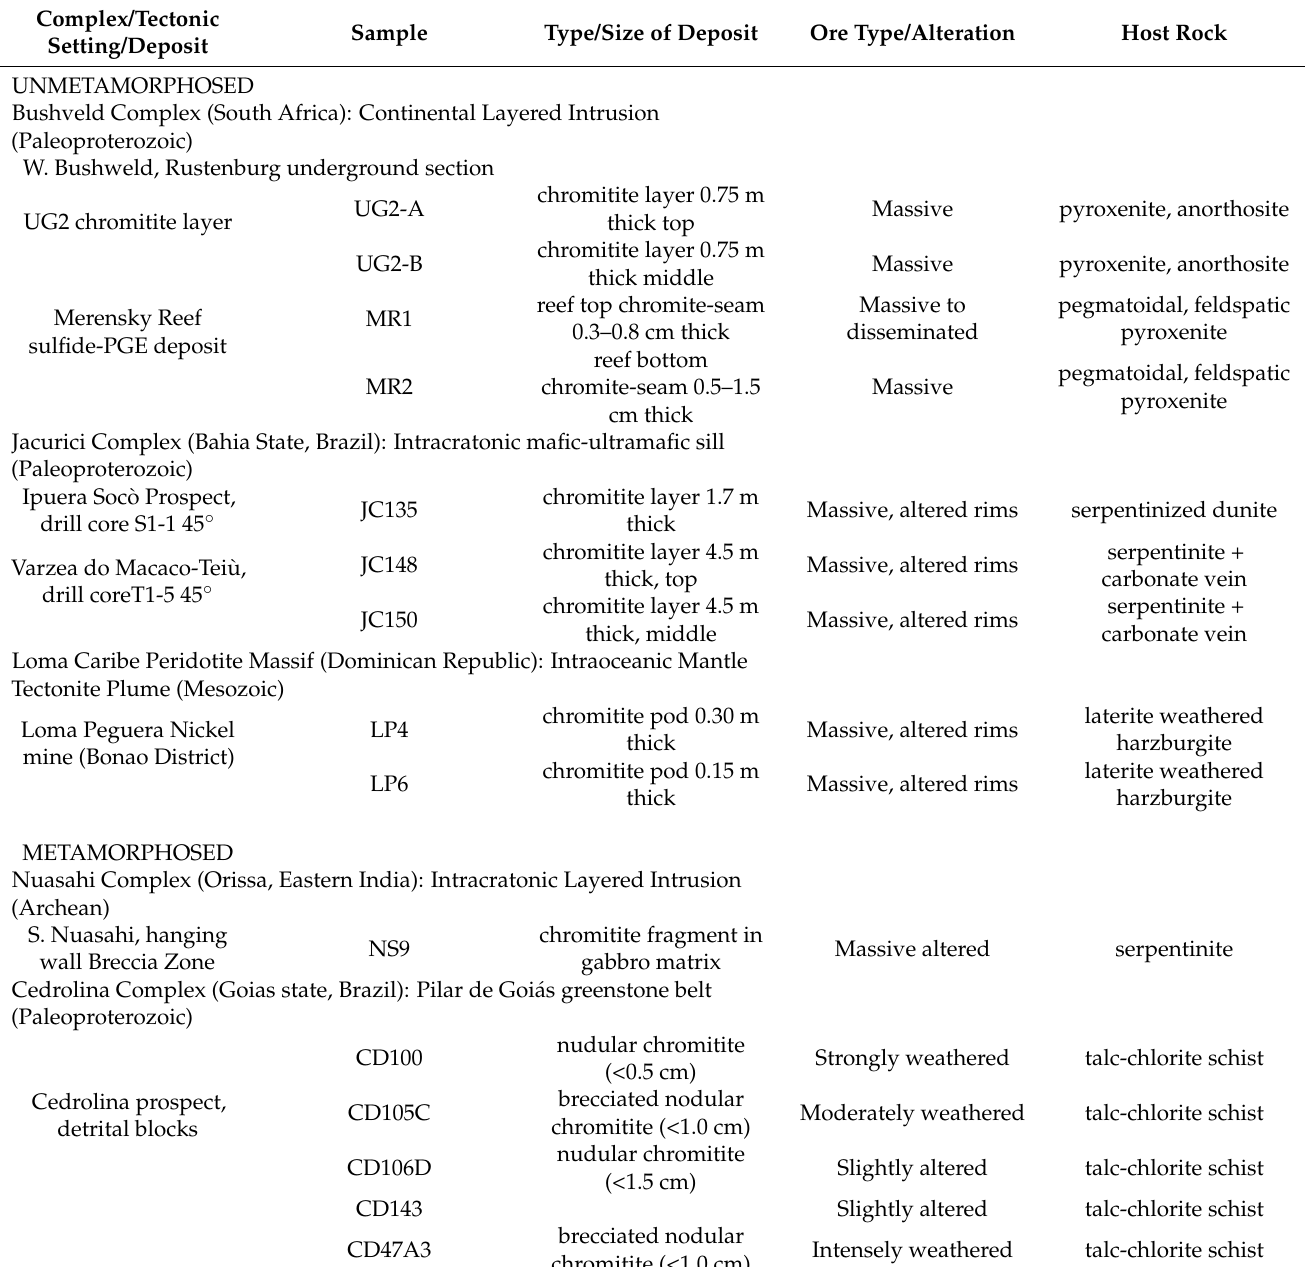
Table 1. Mafic-Ultramafic complexes host of rutile-bearing chromitite and sample